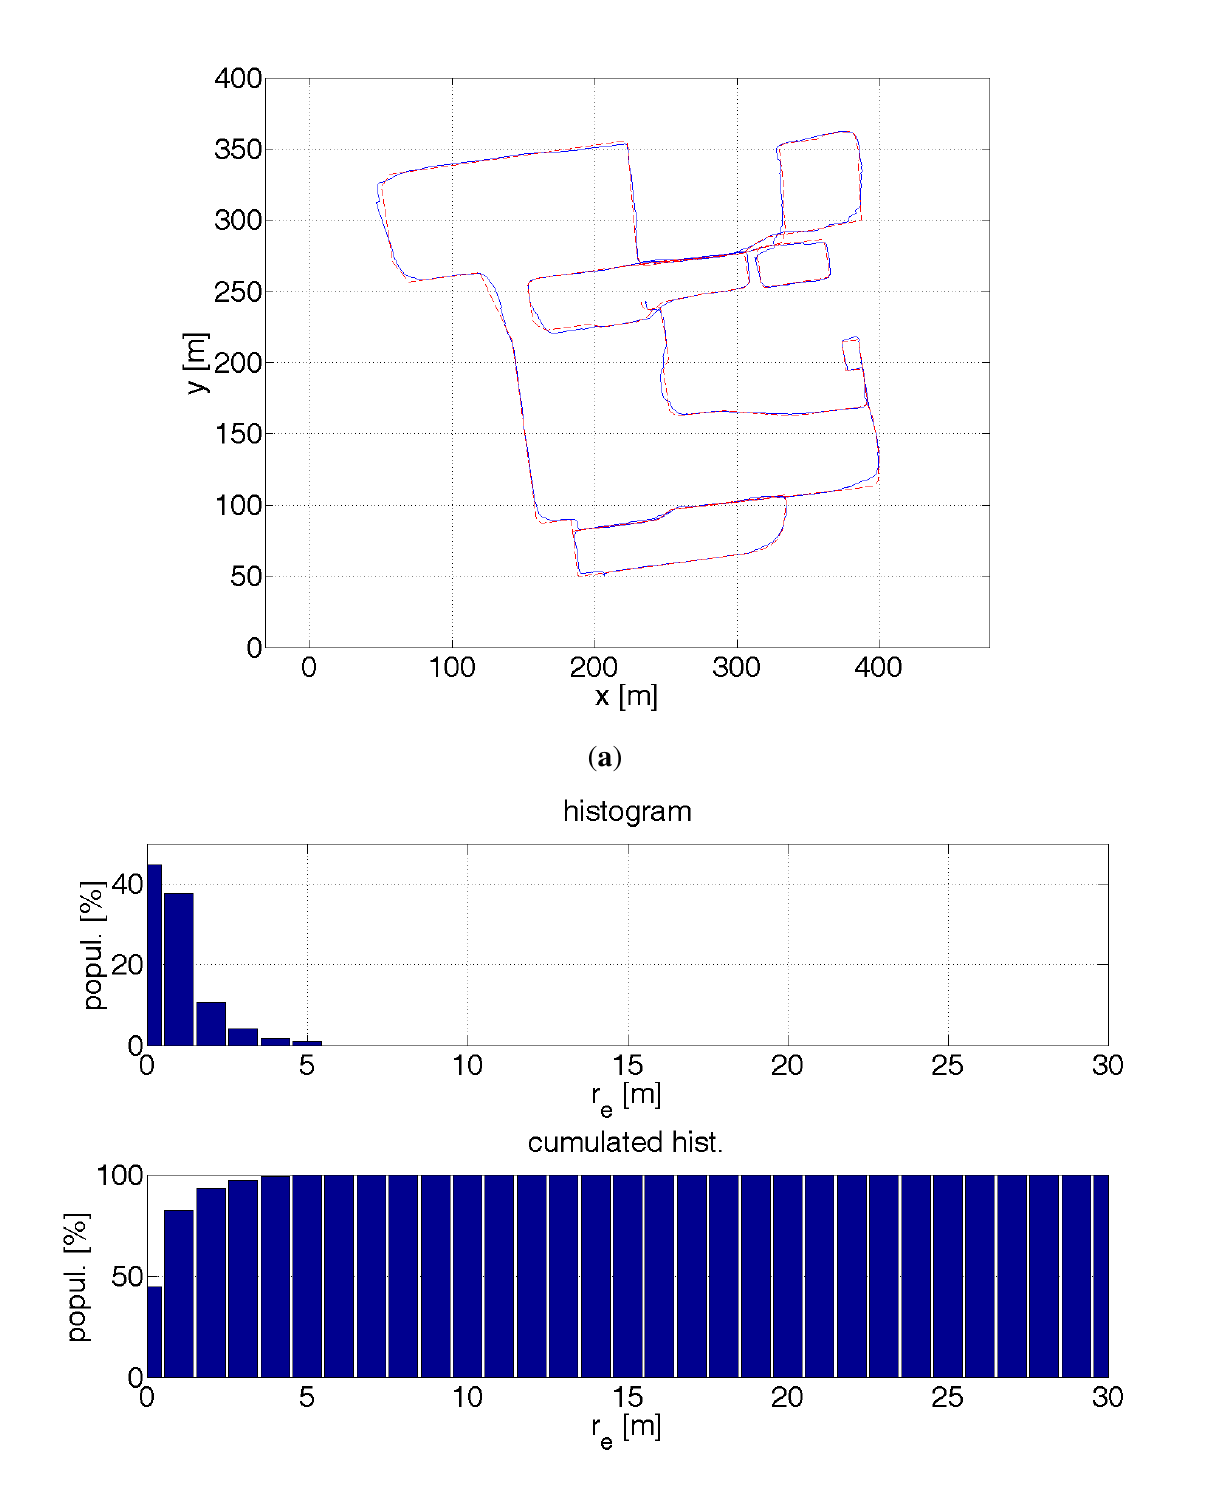
Figure 19. ( a ) Red dashed line—reference path. Blue solid line—estimated path with a help of GPS receiver, inertial sensors, probability map, stereo camera and 3D model of the environment. The positioning is quite precise. The errors are mainly introduced by the error in estimating the heading direction. ( b ) Histograms of distance